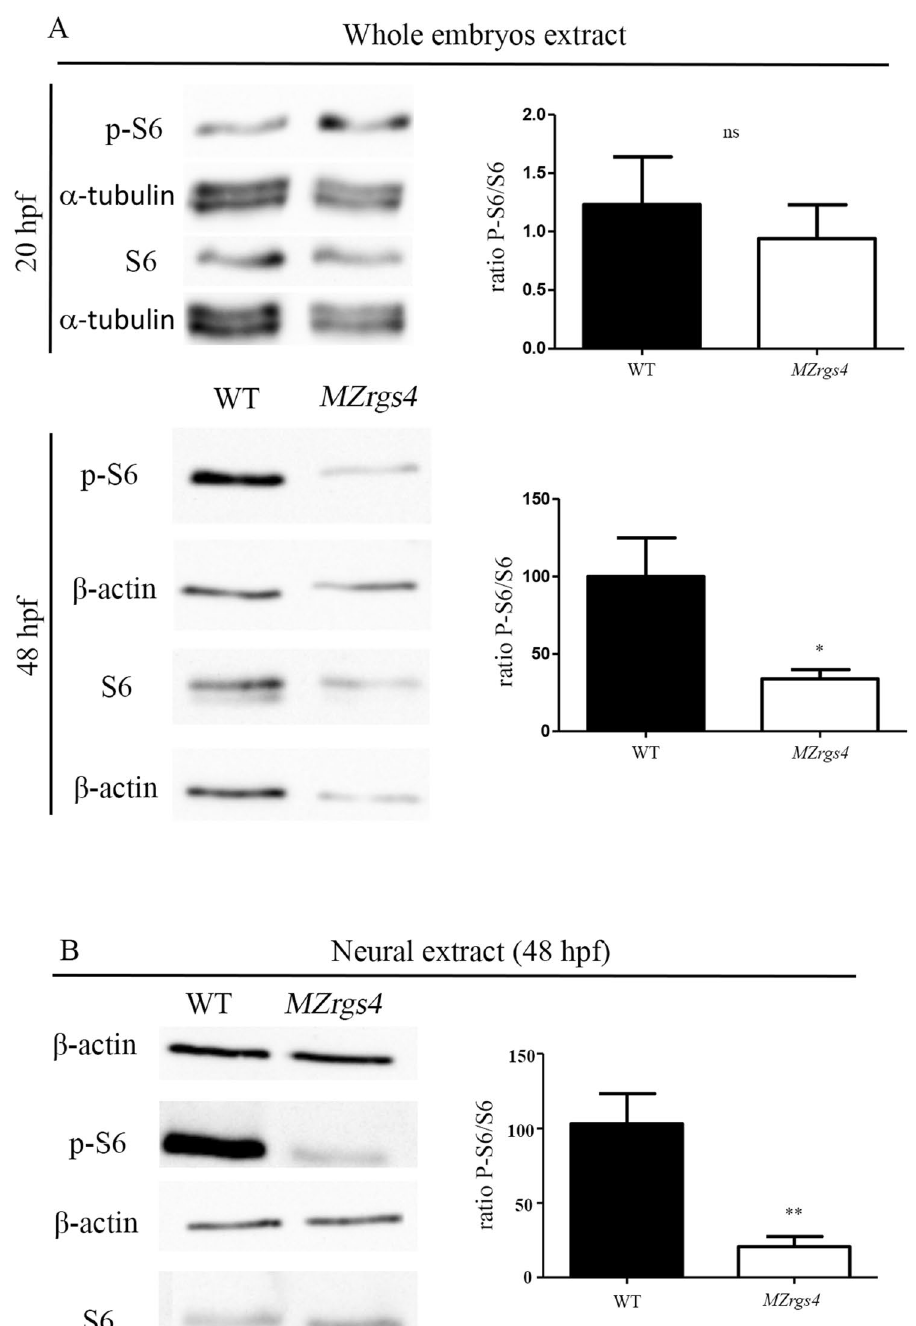
Figure 7. Loss of rgs4 function alters mTOR signaling in neural cells ( A ) Immunoblotting of lysates from zebrafish embryos at 20 hpf. S6 and p-S6 amounts were normalized to α-tubulin and the ratio of p-S6 relative to S6 was compared between WT and MZrgs4 lysates. No significant difference was observed between the two groups. Immunoblotting of lysates from zebrafish embryos at 48 hpf. S6 and p-S6 amounts were normalized to β-actin and the ratio of p-S6 relative to S6 was compared between WT and MZrgs4 lysates. MZrgs4 embryos show a significant decrease in the amount of p-S6/S6 in comparison to WT. ( B ) Immunoblotting of neural lysates from zebrafish embryos at 48 hpf. S6 and p-S6 amounts were normalized to β-actin and the ratio of p-S6 relative to S6 was compared between WT and MZrgs4 lysates. MZrgs4 embryos showed a significant decrease in the amount of p-S6/S6 in comparison to